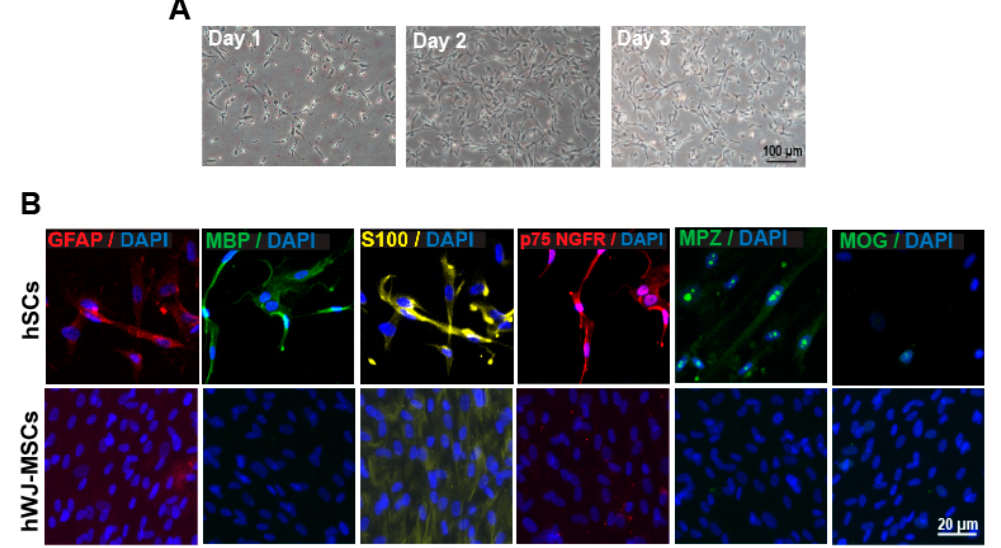
Figure 1. ( A – C ) . ( A ) Morphology of human Schwann cell (hSC) in culture. hSCs were cultured, maintained and assumed a spindle, bipolar shape after 4 days. ( B ) Characterization of hSC through immunocytochemistry. Cultures were immunostained with antibodies against p75 NGFR, GFAP, MPZ, s100, MBP, MOG as indicated in the figure. hSCs do not express MOG. All cultures were counterstained with 4 ′ ,6-diamidino-2-phenylindole (DAPI) (blue). Human Wharton jelly mesenchymal stem cells (hWJ-MSCs) were used as the negative control.